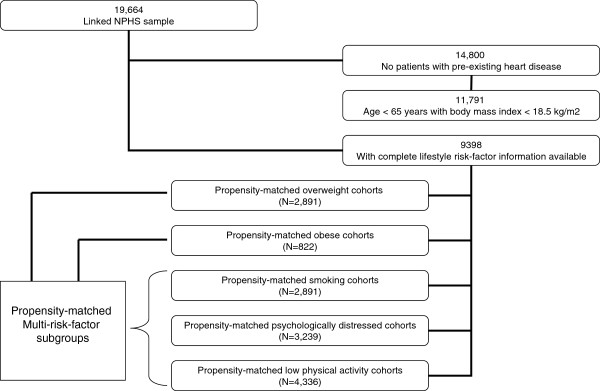
Study sample eligibility subdivided according to subgroups used in propensity analyses NPHS = National Population Health Survey.